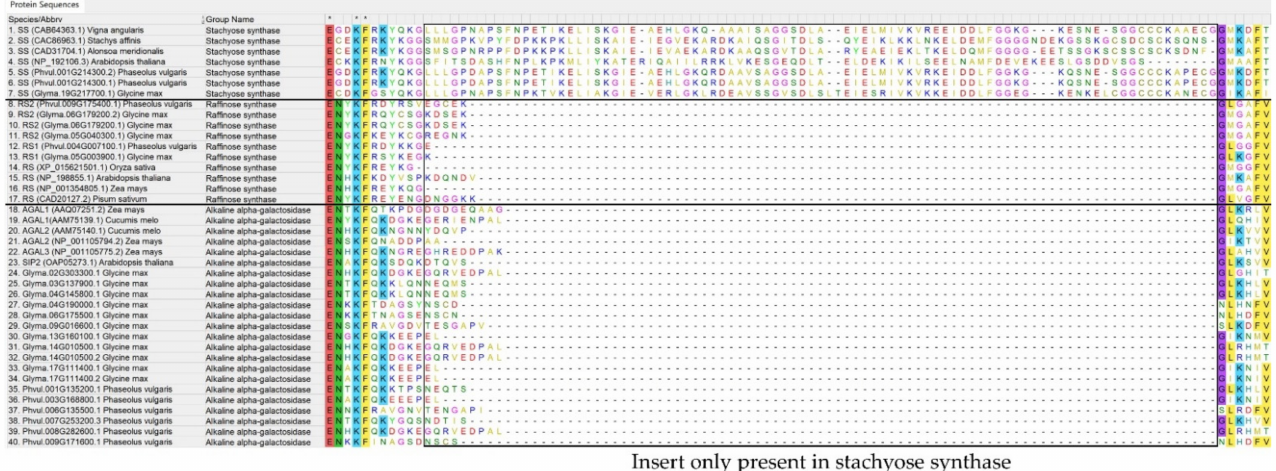
Figure A2. Visualization of the amino acid insert only present in stachyose synthase (SS). A multiple sequence alignment was performed using the MUSCLE algorithm in MEGA X of the protein sequences of potential RFO synthase enzymes of G. max and P. vulgaris together with well-characterized RFO synthase and alkaline α -galactosidase enzymes of O. sativa , C. melo , Z. mays , A. thaliana , P. sativum , V. angularis , S. affinis and A. meridionalis . RS can be distinguished from SS because of an insert present only in SS